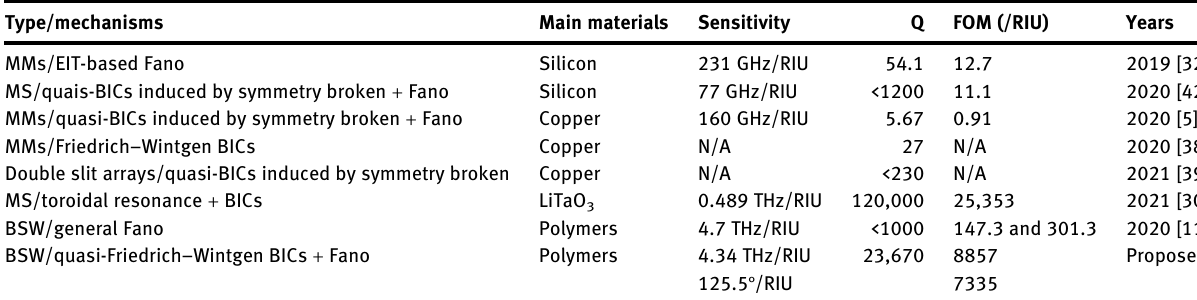
Table  : Parametric comparison of the recently proposed resonators in the THz sensing area. Type/mechanisms